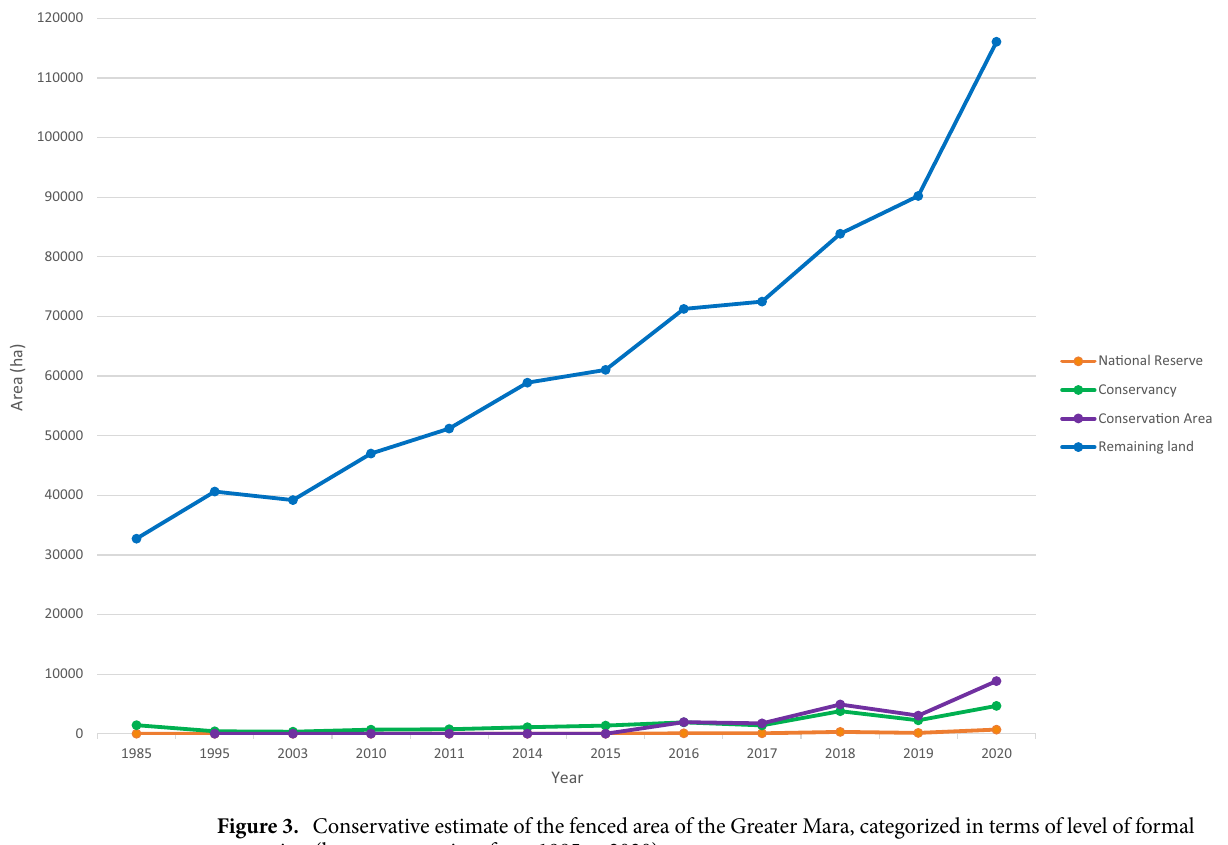
Figure 3. Conservative estimate of the fenced area of the Greater Mara, categorized in terms of level of formal protection (hectares over time from 1985 to